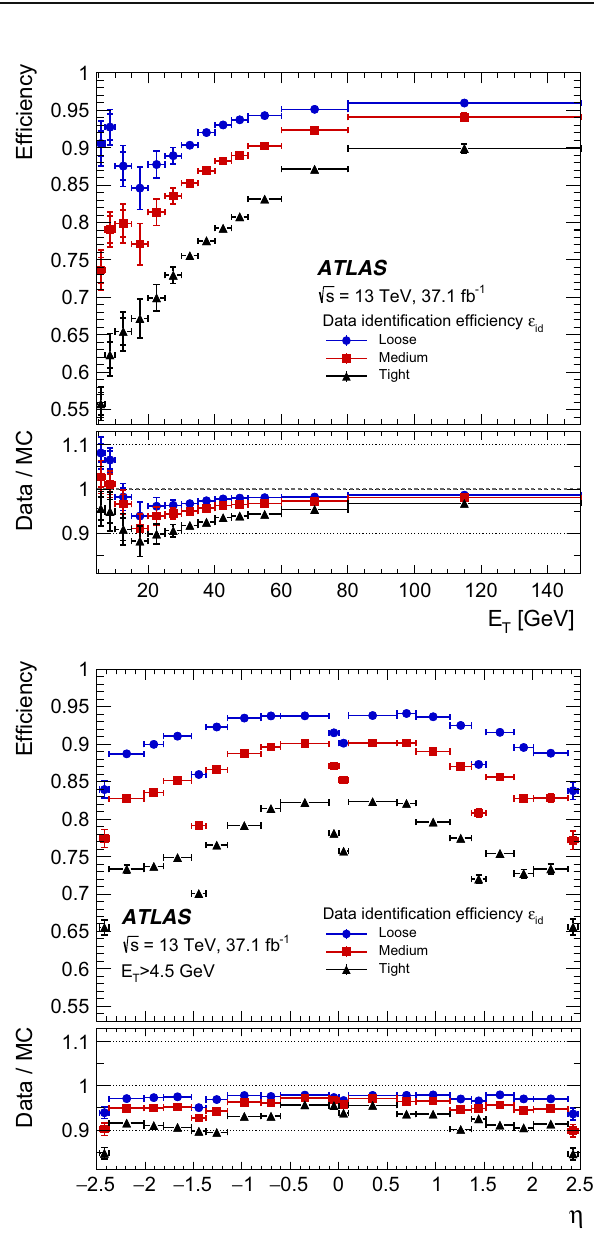
Fig. 8 Measured LH electron-identification efficiencies in Z → ee eventsfortheLoose(bluecircle),Medium(redsquare),andTight(black triangle) operating points as a function of E T (top) and η (bottom). The vertical uncertainty bars (barely visible because they are small) rep- resent the statistical (inner bars) and total (outer bars) uncertainties. The data efficiencies are obtained by applying data-to-simulation effi- ciency ratios that are measured in J /ψ → ee and Z → ee events to the Z → ee simulation. For both plots, the bottom panel shows the data-to-simulation